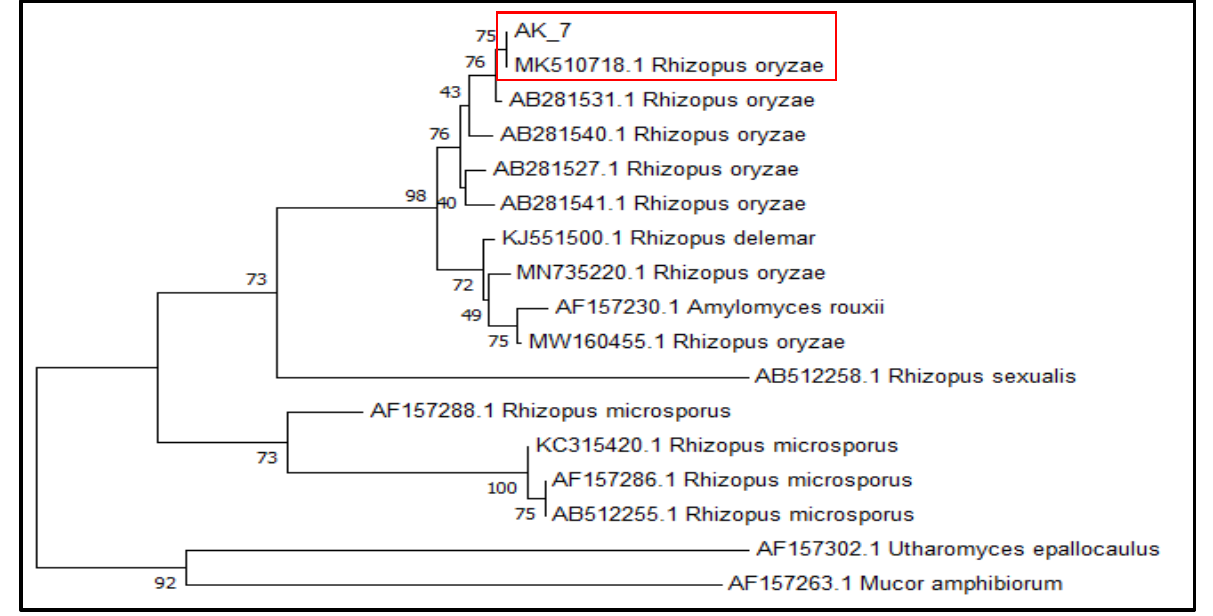
Figure 4. Phylogenetic study of the isolated R. oryzae sequence with 16 closely related EF-1 α sequences after BLAST analysis. After 1000 replicates, the bootstrap values are presented at the branch points.